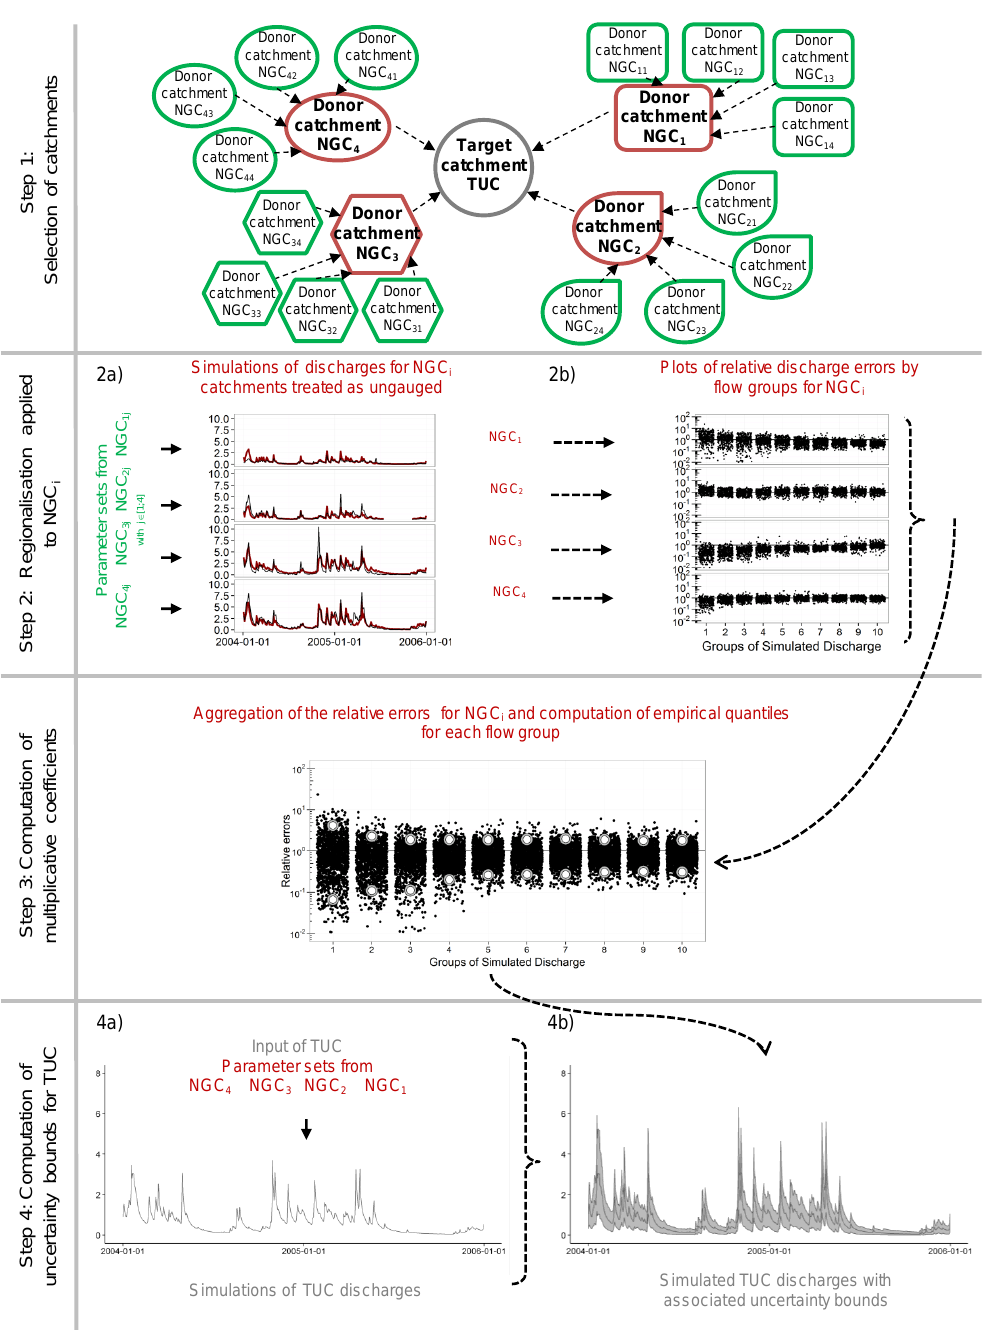
Figure 1. Illustration of the proposed approach, in the case of n = 4 donors. Red catchments are first-level donors while green catchments are second-level donors. For Step 2b, the simulated discharge variable ( x axis) is split into 10 equal-size groups. In Step 3, white dots represent the values of the upper and lower multiplicative coefficients for each group. See the text for the description of the four